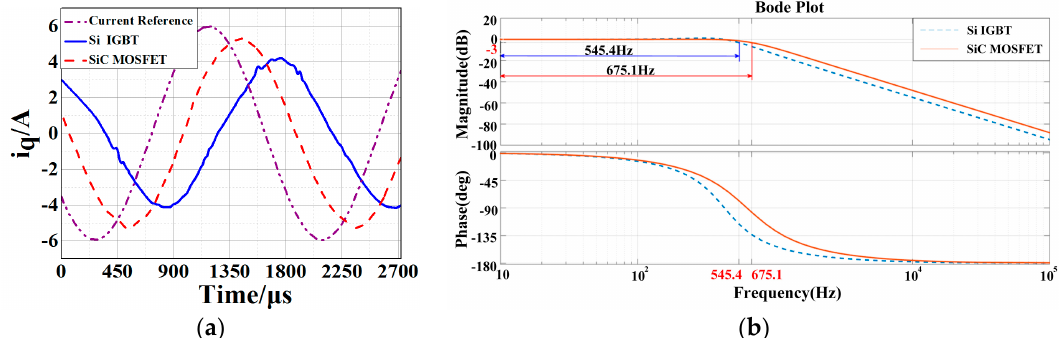
Figure 11. The q -axis current tracking experimental results. ( a ) Commanded and actual q -axis current. ( b ) Bode plot of systems at 15 kHz switching frequency and 2 µ s dead time.